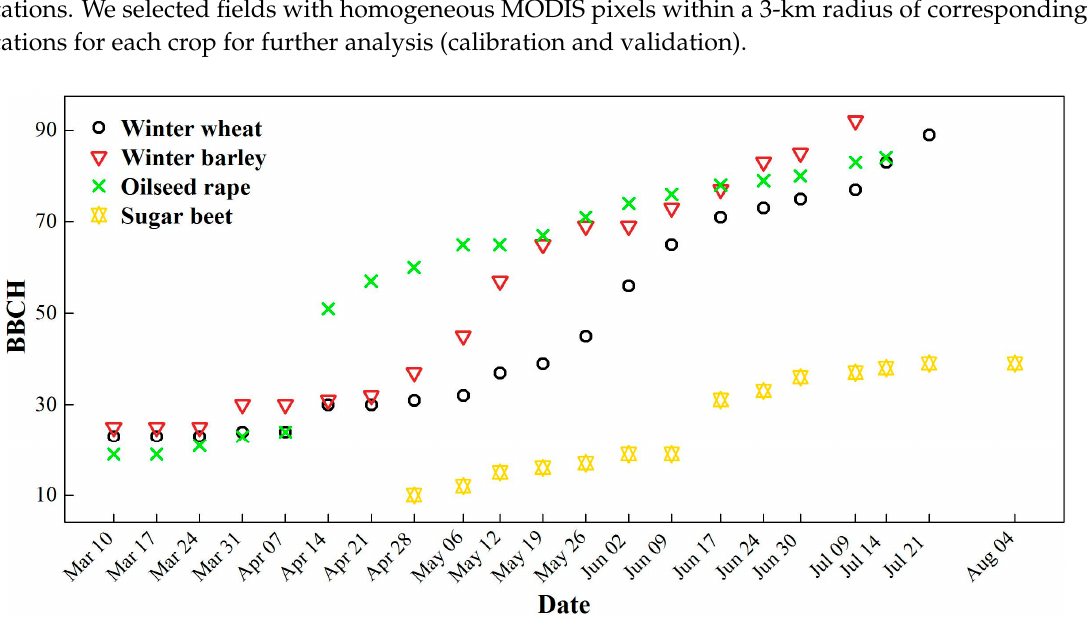
Figure 2. BBCH stages for four crop species from our own field measurements (hereafter referred to as UFZ data) in 2015.